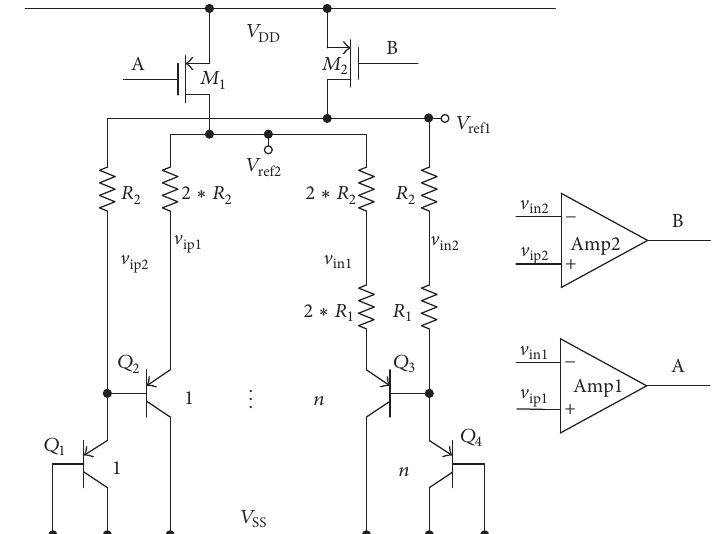
Figure 3: Improved low-offset BGR circuit.